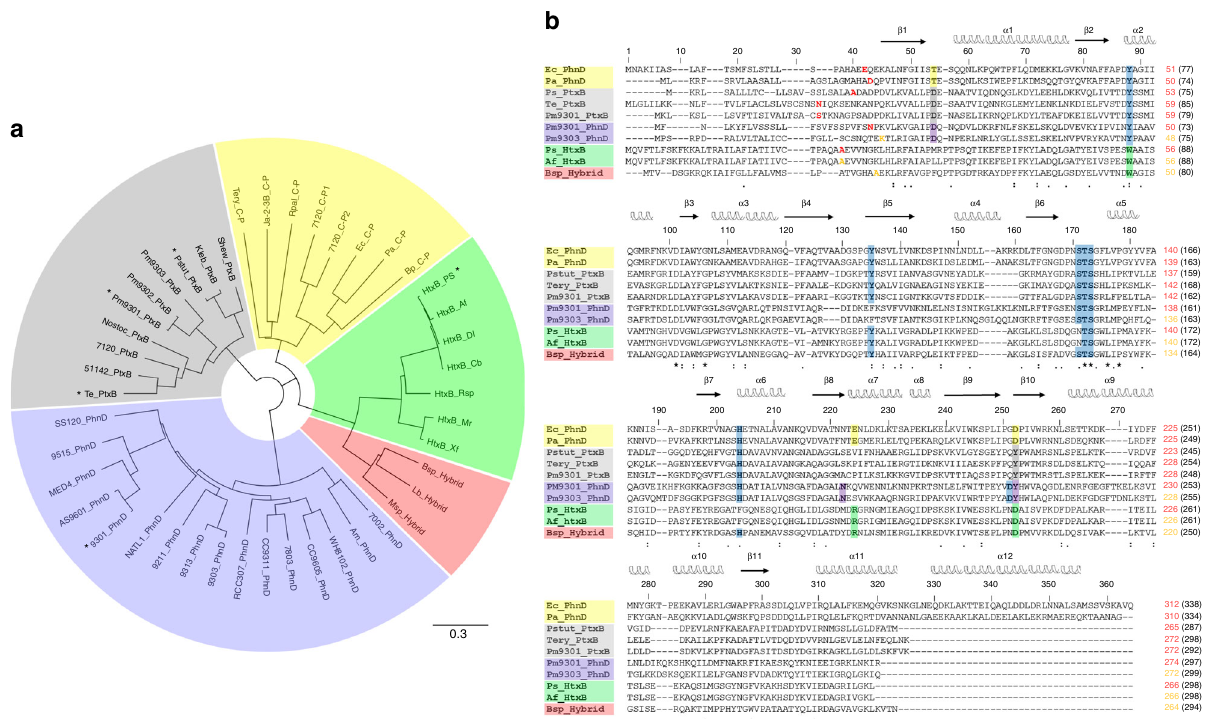
Fig. 5 Protein phylogeny and sequence alignments of reduced phosphorus compound PBPs. a Unrooted phylogenetic tree of reduced P compound transporter PBP amino-acid sequences. Phosphite binding PtxB (grey) and PhnD (purple) homologues cluster separately from each other and from C-P lyase-linked phosphonate binding PhnDs (yellow), HtxB homologues (green) and a putative ‘ hybrid ’ class of transporters (red). Proteins characterised in this study are marked with an asterisk and the scale bar represents the number of substitutions per site. b Sequence alignment of reduced phosphorus compound binding PBPs, coloured as in a . 2-Aminoethlyphosphonate-speci fi c cap residues are highlighted yellow, phosphite-speci fi c cap residues are highlighted grey (PtxB) or purple (PhnD) and hypophosphite-speci fi c cap residues are highlighted green. Conserved residues that form H-bonds with ligand oxygen atoms are highlighted in blue. The position in the alignment is shown above the sequence and residue numbering for each protein at row ends. For residue numbering, the red (or orange, see below) value corresponds to the residue numbering of the structures, as the predicted N-terminal signal peptides were not present in recombinant proteins, and the black number in parentheses is the residue number of the unprocessed proteins. The second residue (following the initiator Met1) in the recombinant proteins used in this study is shown in red and bold in the sequence; in the case of proteins not directly studied here, the equivalent residues/residue numbers are shown in orange. For full details of the proteins included in this fi gure